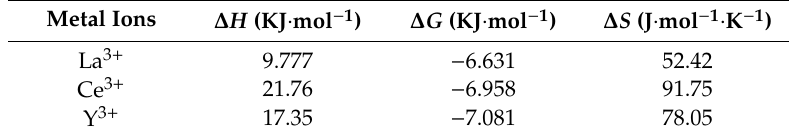
Table 4. Results of desorption efficiency.